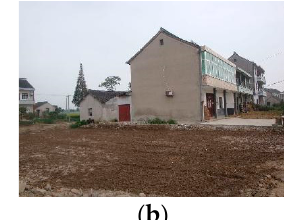
11 of 22 Figure 9. Parcel map of construction land (source: https://td.szggzy.com/tiaim/web/landDe- tail?id=20200912181648914840102076418611&code=0015&goodId=20200912181648908466638201444 667 , 26 October 2021 ). Examples of construction land are demonstrated in Figure 10. Construction land for specific usages, for instance, land for mining, industry and residential land in urban areas, also lie aboveground and underground. The spatial forms of aboveground areas are typ- ically irregular. However, these property units can be considered “open type” properties. These realty registrations should incorporate physical conditions and rights information. The basic unit of mining areas should be defined by its longitude and latitude according to the Rules for the Implementation of the Mineral Resources Law of the People’s Republic of China. The spatial forms of underground regions can be irregular in 3D space. There- fore, these forms can be considered “fully delimited type” properties because the owner- ship of the property is uniform (distinctions between exploration rights and mining rights should be considered). If the underground regions of a mining area intersect with other property units, such as buildings or ponds, then these sections of the property unit should be regarded as adjoining, sharing common boundary surfaces. ( a ) ( c ) Figure 10. Spatial forms of construction land: ( a ) mining area; ( b ) building area; ( c ) construction land 4.5. Homestead Land Homestead land is collectively owned land that is occupied and utilized as residen- tial land by peasant households or individuals in rural areas. Three main types of home- steads exist: (1) land on which houses have been built (Figure 11b), (2) land with roofless buildings that cannot provide living functions (Figure 11a), and (3) land that is intended for houses. A registration chart for a homestead is shown in Figure 12. The registration form and